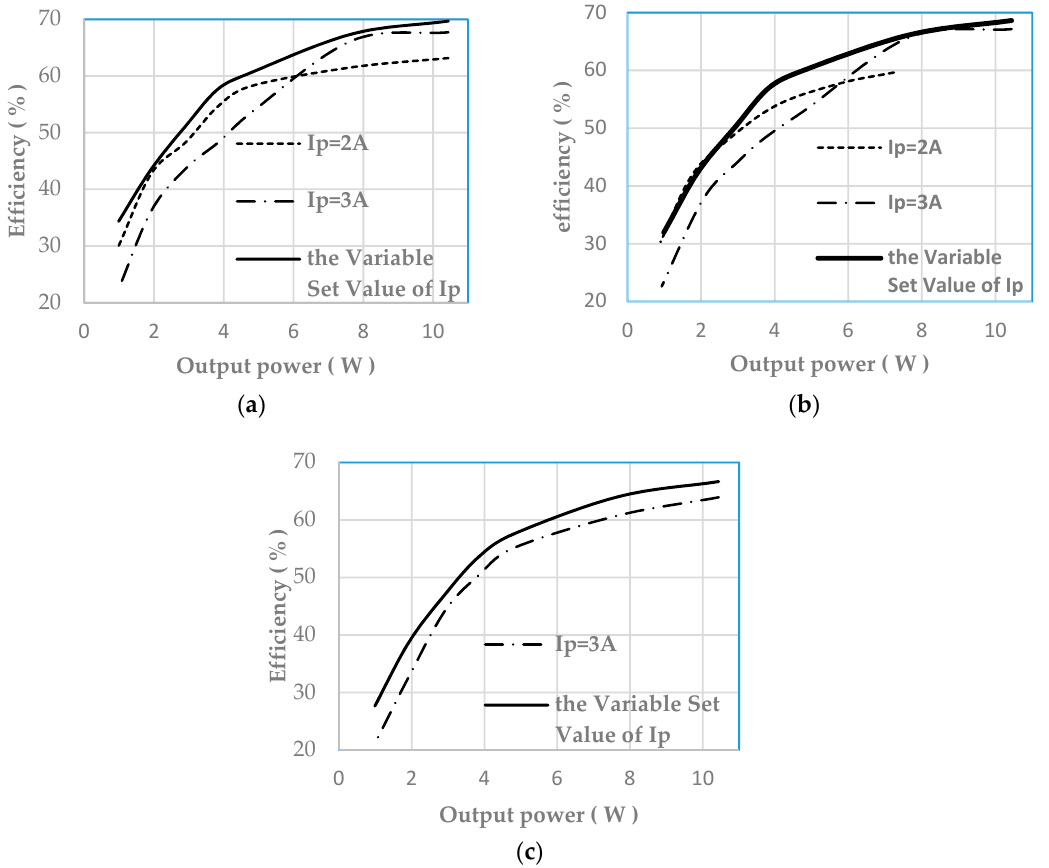
Figure 12. Comparison of efficiencies at different primary currents: ( a ) vertical distance of coils is 1.2 cm ( k = 0.51); ( b ) vertical distance of coils is 1.5 cm ( k = 0.40); ( c ) vertical distance of coils is 1.8 cm ( k = 0.29). When the vertical distances of coils are 1.8 cm, 1.5 cm, and 1.2 cm, the coupling coefficients are 0.29, 0.40, and 0.51, respectively. If the vertical distance of coils is 1.2 cm and the misalignment horizontal distances of coils are 1.3 cm, 0.9 cm, 0 cm, the coupling coefficients are 0.29, 0.40, and 0.51, respectively. The experiments at different misalignment horizontal distance are similar to the ones at different vertical distance if the coupling coefficients are the same.